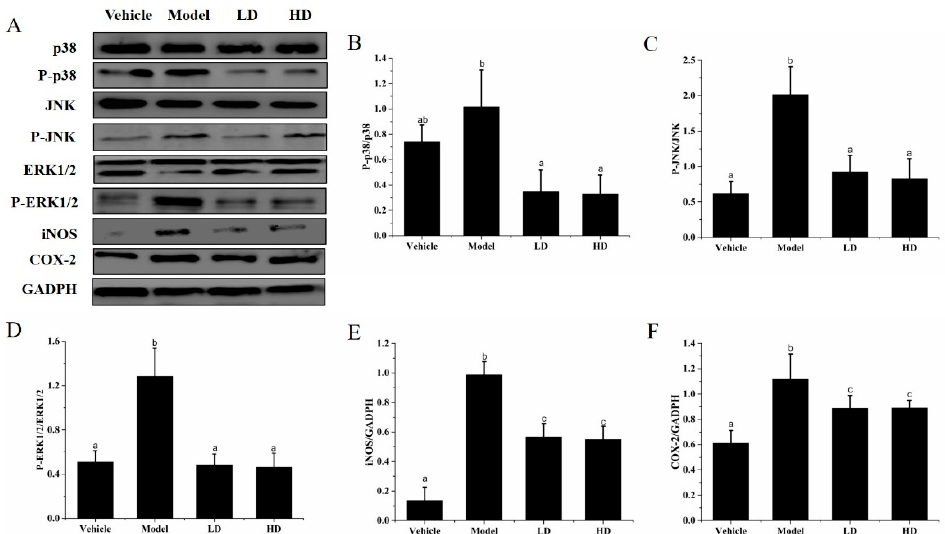
Figure 6. Effect of SAVEP on inflammatory protein expression in inflammatory-damaged RAW264.7 cells. ( A ) Expression levels of proteins were detected through Western blot analysis. ( B ) Quantitative analysis of P-p38/p38 protein level. ( C ) Quantitative analysis of P-JNK/JNK protein level. ( D ) Quantitative analysis of P-ERK1/2/ERK1/2 protein level. ( E ) Quantification of iNOS protein expression. ( F ) Quantification of the COX-2 protein expression. Statistical analysis was performed using a one-way ANOVA with Tukey’s test. Data represent the mean ± SD ( n = 6). Different letters represent significant differences between groups ( p < 0.05).